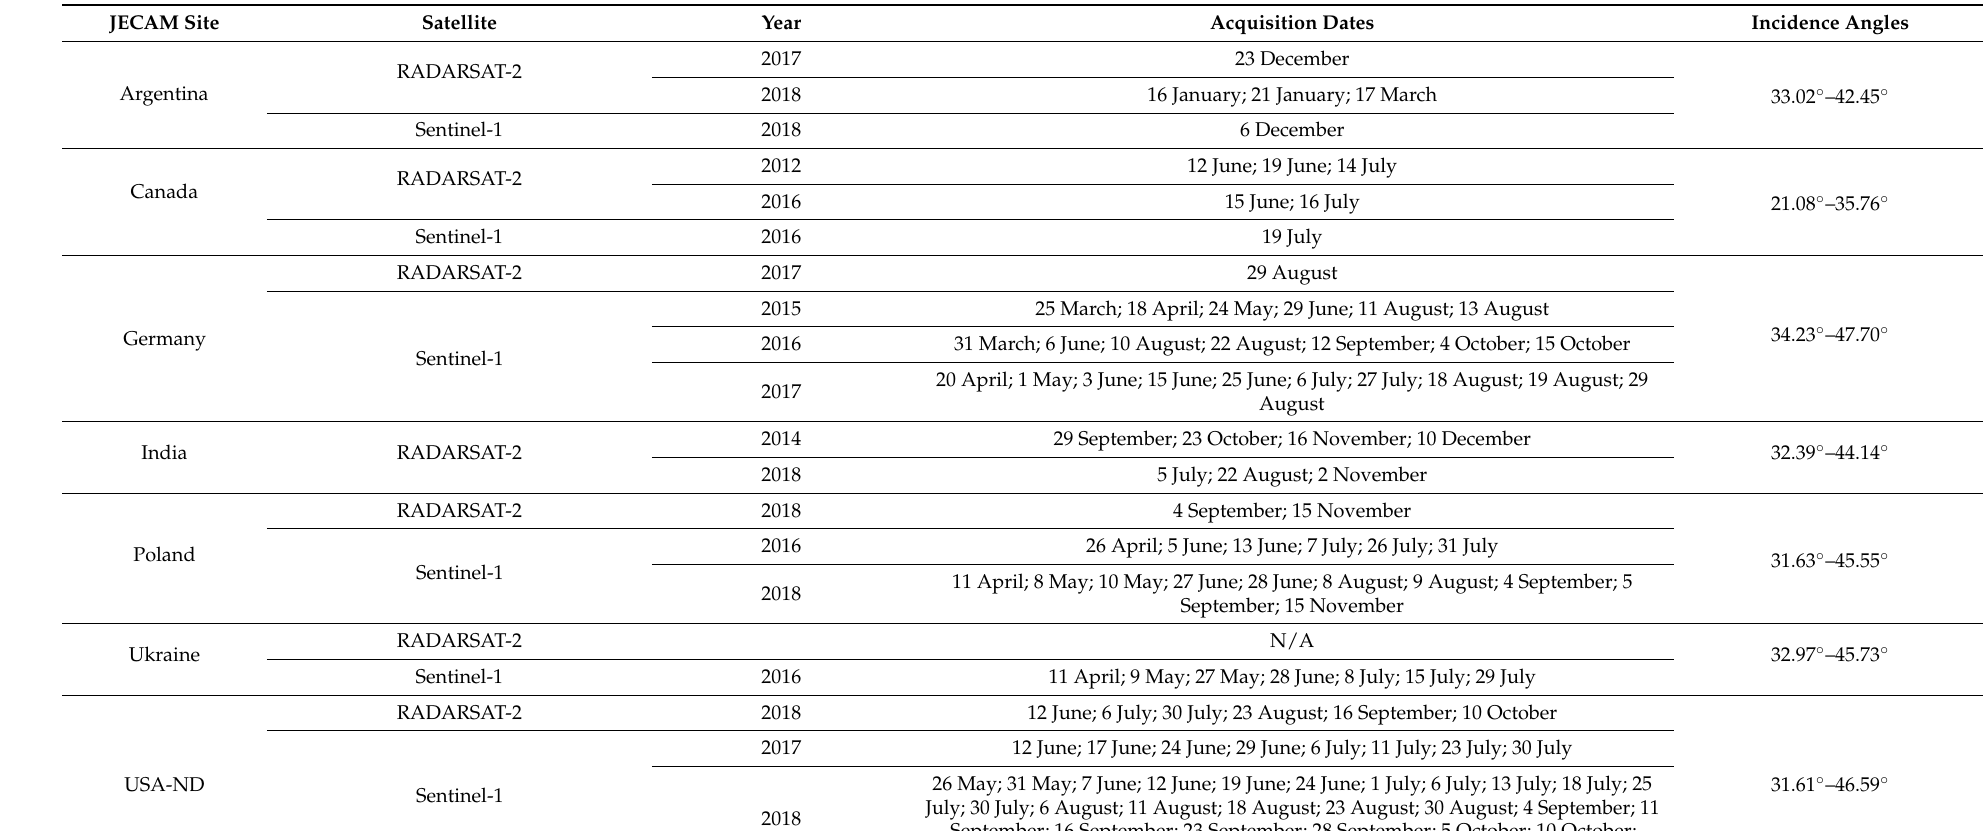
Table 2. Dates of RADARSAT-2 and Sentinel-1 image acquisitions over the JECAM